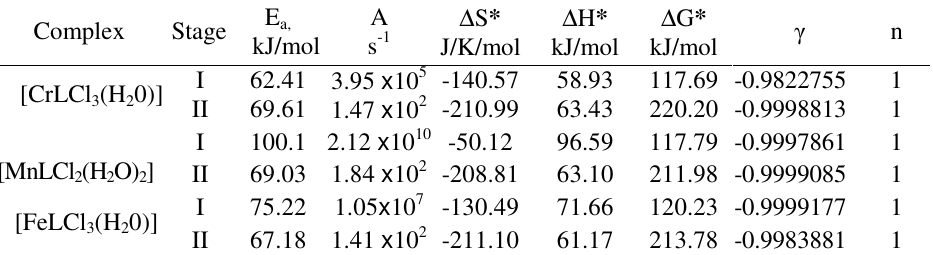
Structures suggested for different complexes are given in Figure 5 and 6.